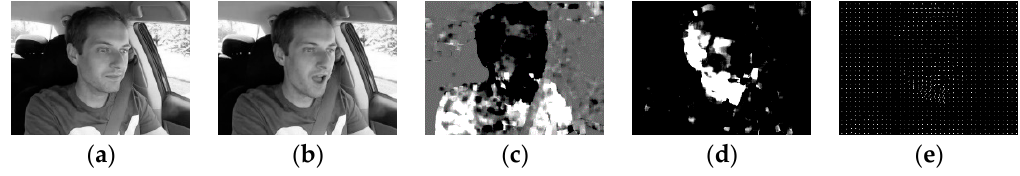
Figure 7. Farneback algorithm related images. ( a ) and ( b ): A pair of adjacent frames. ( c ) Horizontal component of the displacement vector field. ( d ) Vertical component of the displacement vector field. ( e ) A close-up of dense optical flow for the adjacent frames.